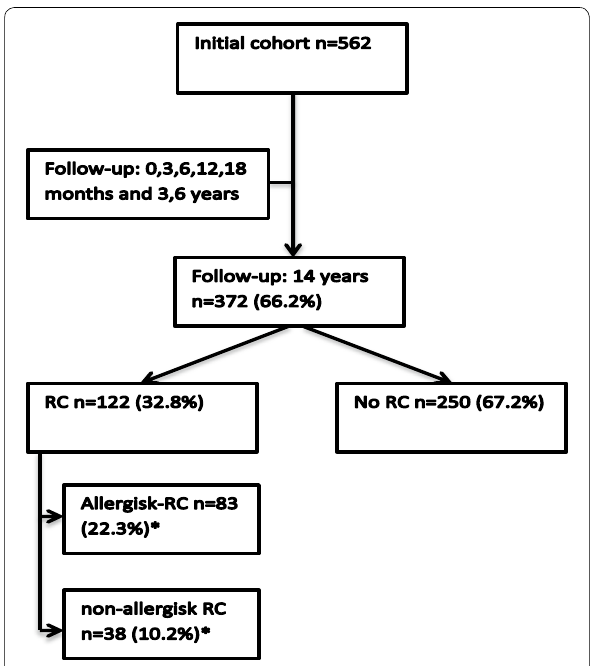
Fig. 1 Flow‑chart of the DARC cohort and the distribution of rhino‑ conjunctivitis (RC) in the 14 years follow‑up investigation. Reference group was no RC. *One participant with RC had neither SPT nor IgE measured therefore could not be categorized as allergic or non‑ allergic